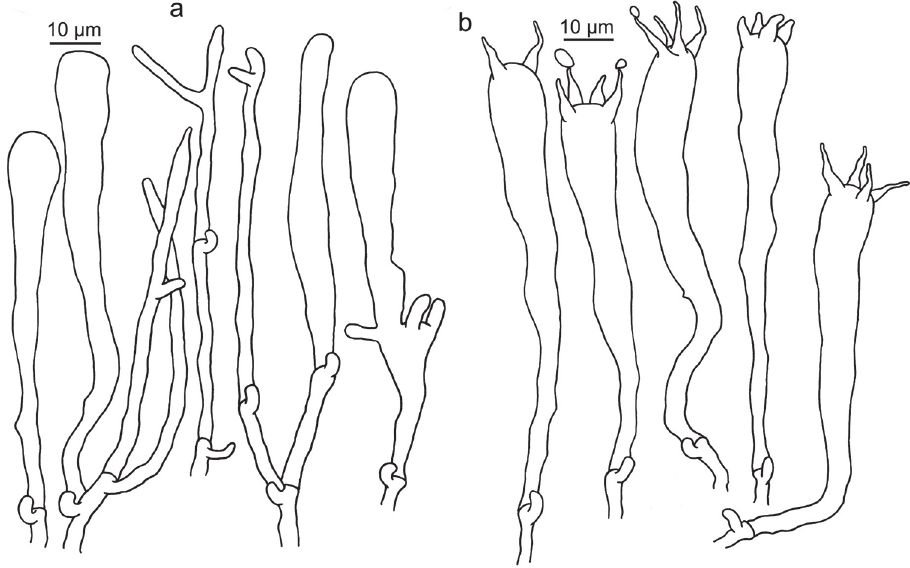
Figure 11. Microscopic features of Clavariadelphus khinganensis (MHHNU 7789, holotype). a Lepto- cystidia and immature basidia b